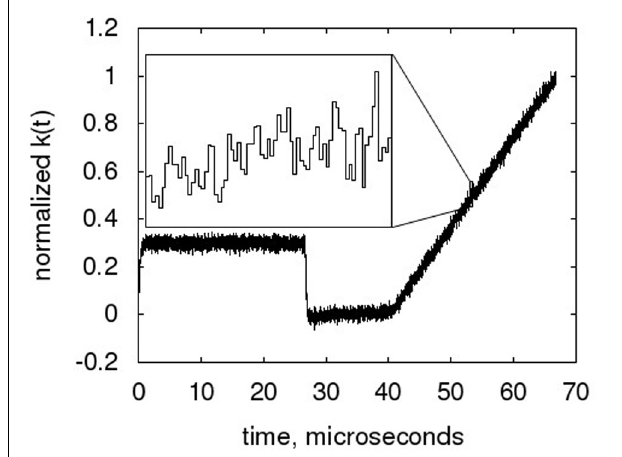
FIGURE 10 | Sample time course of the low-pass filter, with zoom of the ramp part of the waveform. The NEF ADC is configured to the hardware baseline characteristic, but with only 128 neurons and = 107ns (equiv. 16ms) to reduce resolution and thus enhance the τ PSC visibility of the curve progression from output code to output code.